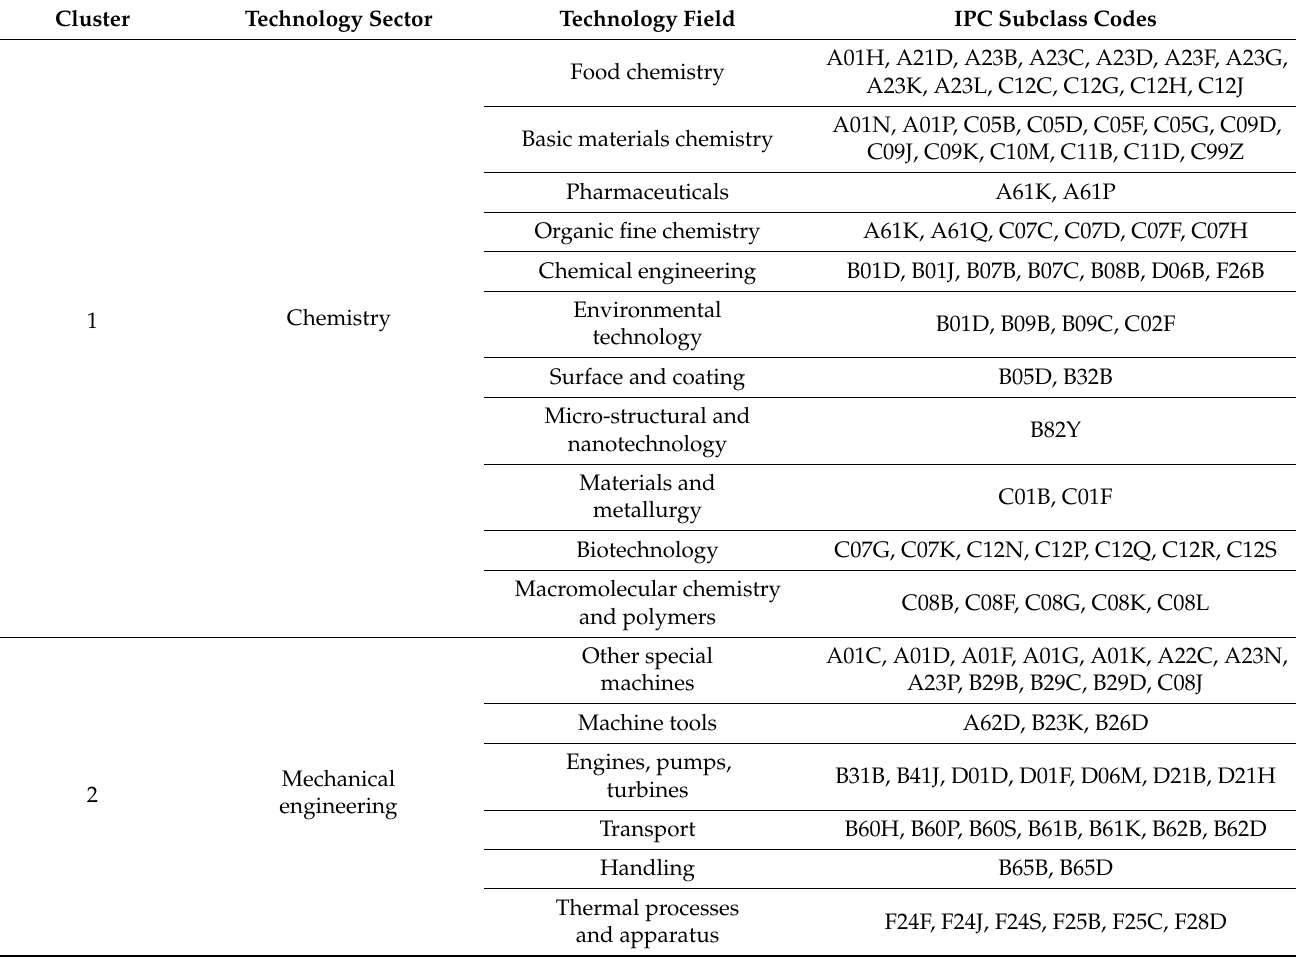
Table 3. Five technology sectors based on K-means clustering algorithm.